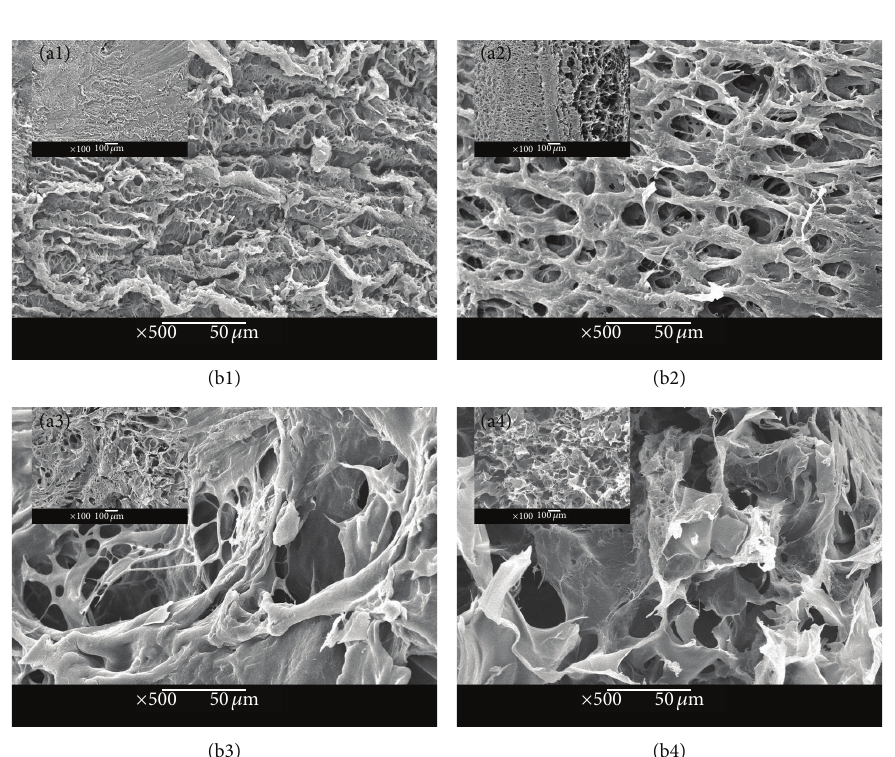
Figure 1: SEM micrographs of the surface sections of PVA hydrogel and PVA with additives: ((a1), (b1)) IPN-1 with 15% w/v PVA; ((a2), (b2)) IPN-2 with 2% w/v gelatin; ((a3), (b3)) IPN-3 with 5%w/v gelatin; ((a4), (b4)) IPN-4 with 7% w/v gelatin; after 1 and 3 of freezing-thawing cycles, respectively. Scale bar (a1)–(a4): 100( 𝜇 m); (b1)–(b4): 50 ( 𝜇